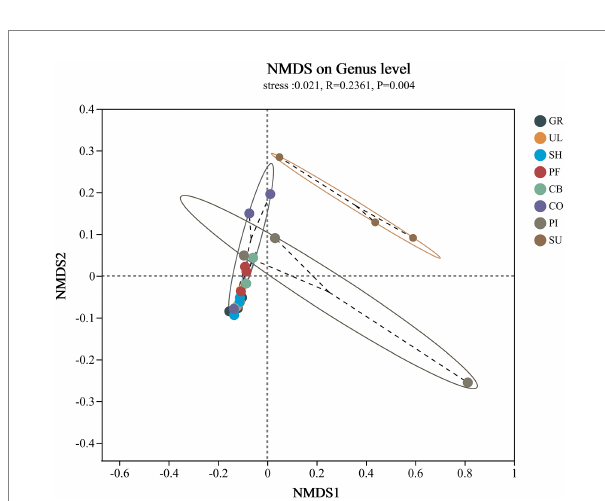
FIGURE 4 NMDS analysis of the β -diversity of soil AMF communities at different